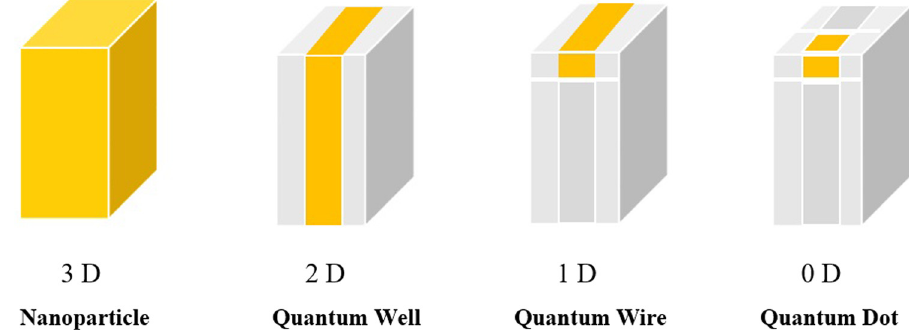
Figure 5: Di ff erent con fi nement directions structures.